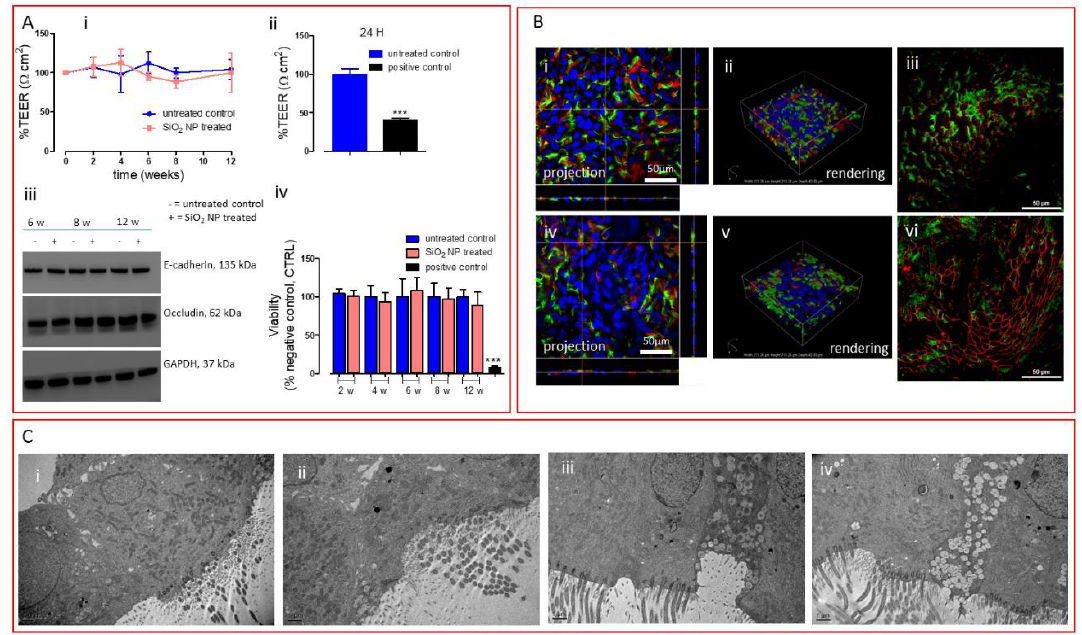
Figure 2. ( A ) ( i ) TEER measurements of the 3D airway model untreated or treated with repeated SiO 2 NP aerosolization (2, 4, 6, 8, and 12 weeks). ( ii ) TEER measurement of the 3D airway model exposed to 0.3% Triton X-100 (24 h) employed as positive control. Data are expressed as mean ± standard deviation ( n tests = 3) and show a percentage relative to the pre-exposure TEER values of each tissue. *** p < 0.001 vs. untreated control cells. ( iii ) Western blot analysis of membrane proteins (E-cadherin and occludin). Representative blots are shown. Quantification of Western blotting was performed with ImageJ software 1.8.0_112 (NIH, Bethesda, MD, USA). GAPDH expression was reported as protein loading control. The experiment was performed twice with comparable results. ( iv ) Viability assay (resazurin method) where 0.3% Triton X-100 was used as positive control for 24 h. Data are expressed as mean ± standard deviation ( n tests = 3). *** p < 0.001 vs. untreated control cells. ( B ) Projection and rendered reconstruction of representative LSCM images of 3D bronchial epithelial cells before SiO 2 NP exposure ( i – iii ) and after 12 weeks of repeated treatment ( iv – vi ). Cells were stained with Hoechst 33342 (nuclei, in blue, all panels), mucin 5AC antibody (goblet cells, in red, panels i, ii, iv, and v), alpha tubulin (acetyl K40) antibody (cilium cells, in green, panels i , ii , iv , and v ), and ZO-1 antibody (tight junction protein, in red, panels iii and vi). Scale bars: 50 µ m (63 × objective lens). ( C ) Representative TEM micrographs of the untreated tissue ( i ) and tissue repeatedly exposed to SiO 2 NPs for ( ii ) 6 weeks, ( iii ) 8 weeks, and ( iv ) 12 weeks. Scale bars: 1 µ